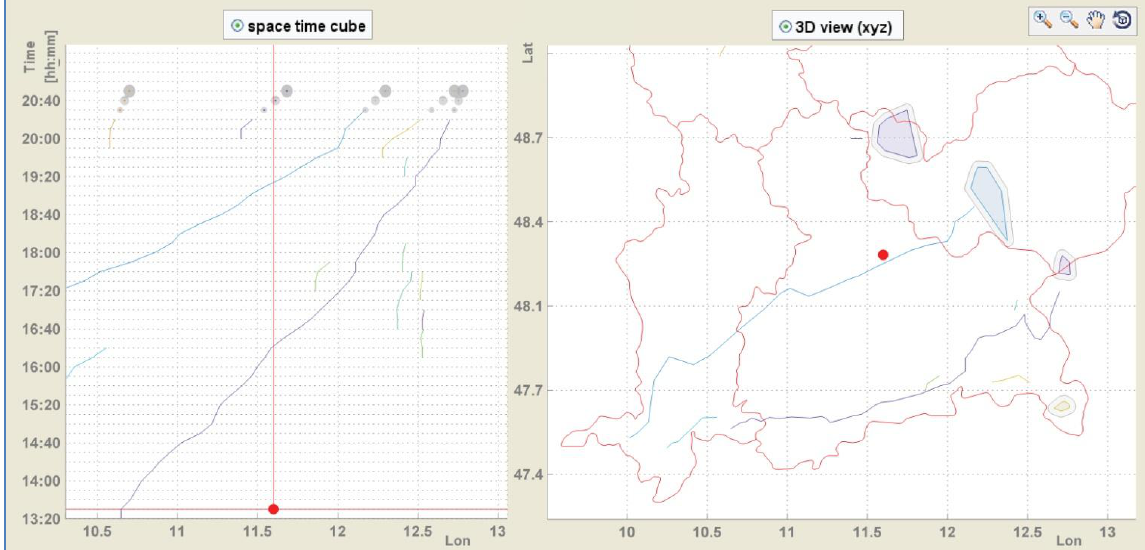
Figure 8. Probability buffer for nowcasted cluster centroids and cluster convex